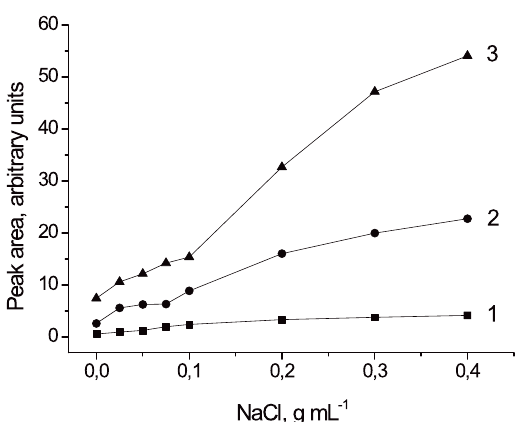
Figure 3. Effect of NaCl content on the peak areas of (1) methylparaben, (2) ethylparaben and (3) propylparaben. Concentration of each analyte is 5 µg mL -1 . Extraction time is 40 min. Solution stirring rate is 1500 rpm.